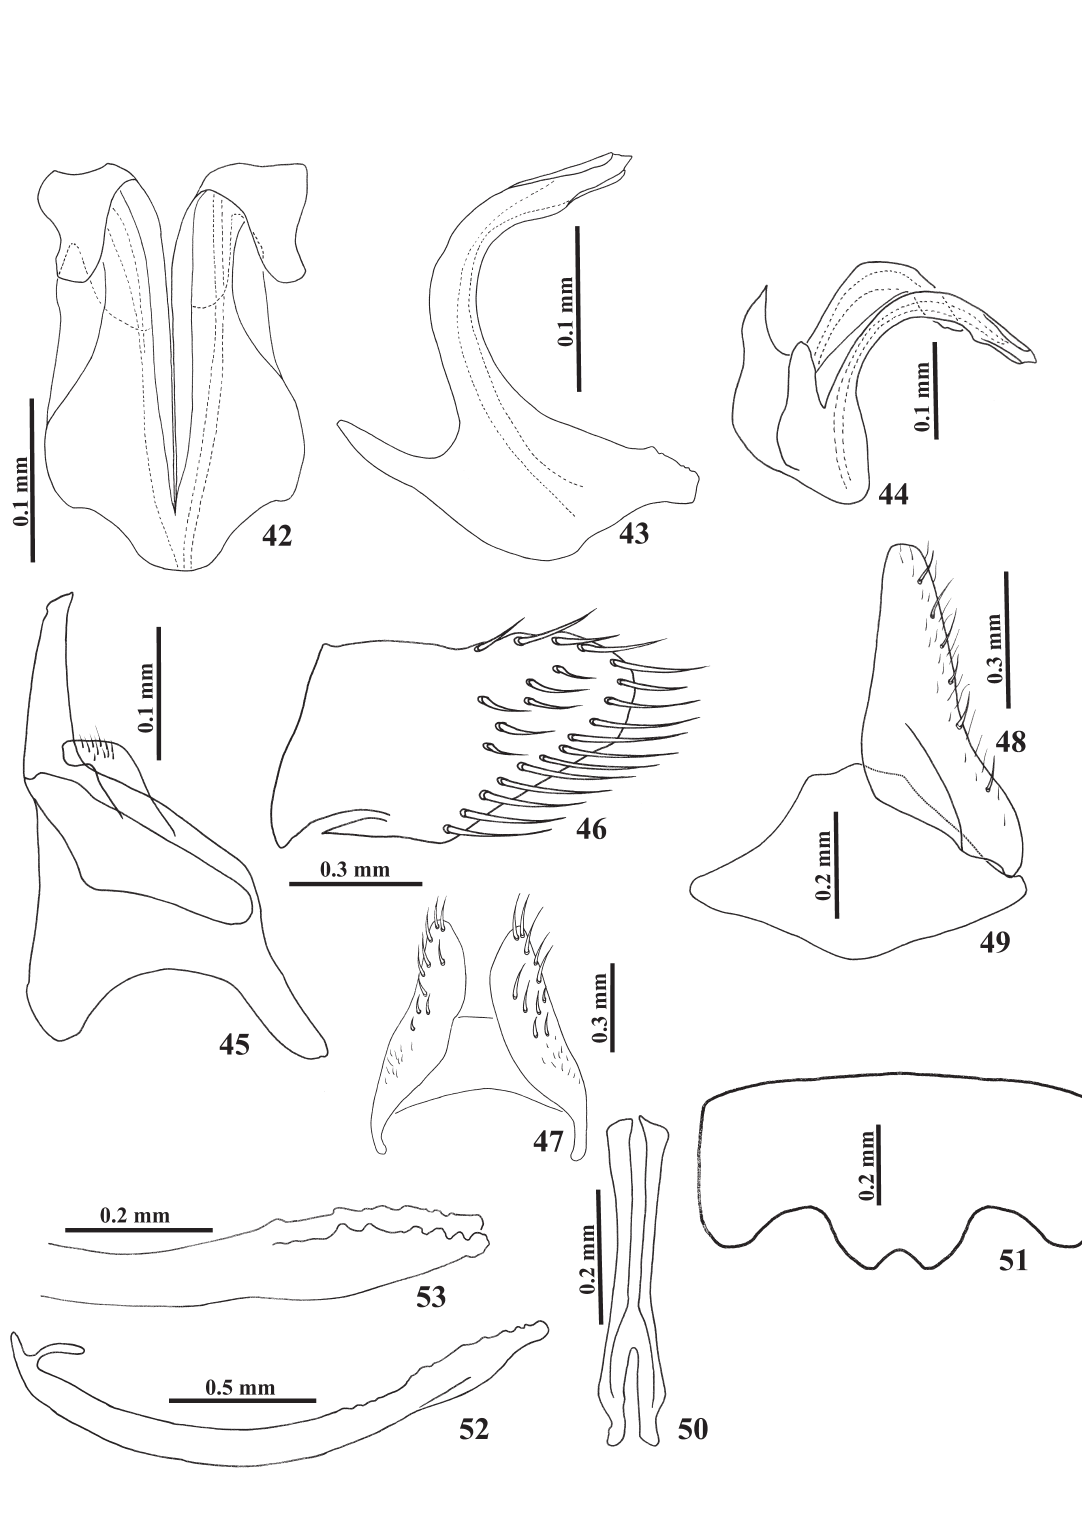
Figs 42–53. Oshaibahus linnavuorii El-Sonbati & Wilson gen. et sp. nov. 42 . Aedeagus dorsal view. 43 , 44 . Lateral view. 45 . Style. 46 . Lateral view of pygofer. 47 . Ventral view of pygofer. 48 . Subgenital plate. 49 . Valve. 50 . Connective. 51 . ♀ 7 th sternite. 52 – 53 . ♀